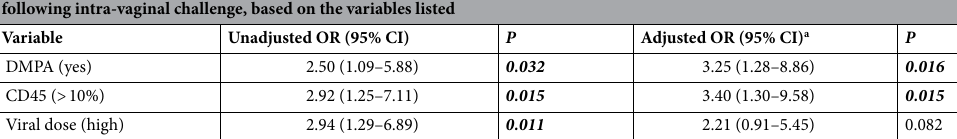
Table 1. The association between HIV-1 infection in humanized mice following intravaginal viral challenge and the listed covariables was estimated in a univariate (unadjusted) and multivariate (adjusted) generalized linear model. P ≤ 0.05 was considered significant. Bold and italicized values indicates statistically significant odds ratios (ORs) a Adjusted by DMPA, CD45, and Dose.